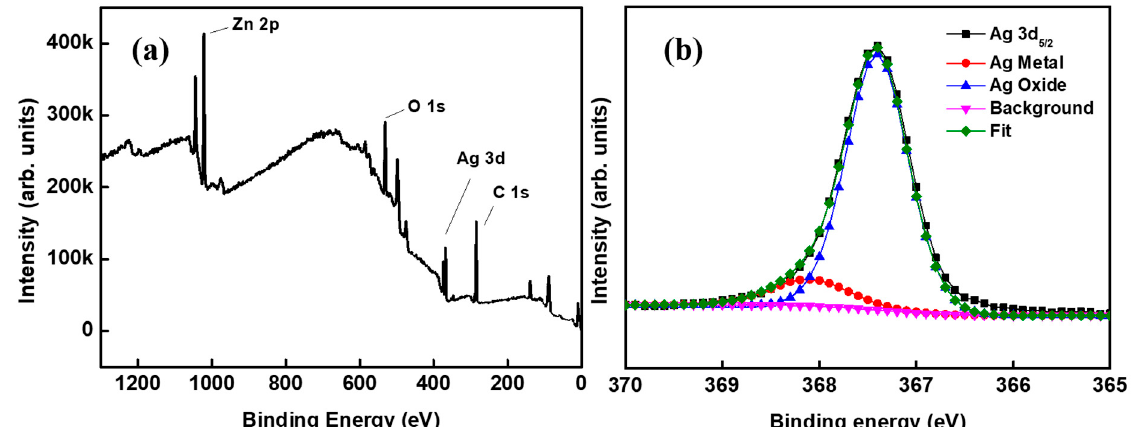
Figure 2. XPS spectra of the sample: ( a ) the full spectrum and ( b ) Ag 3d5/2 peak fitting spectrum.